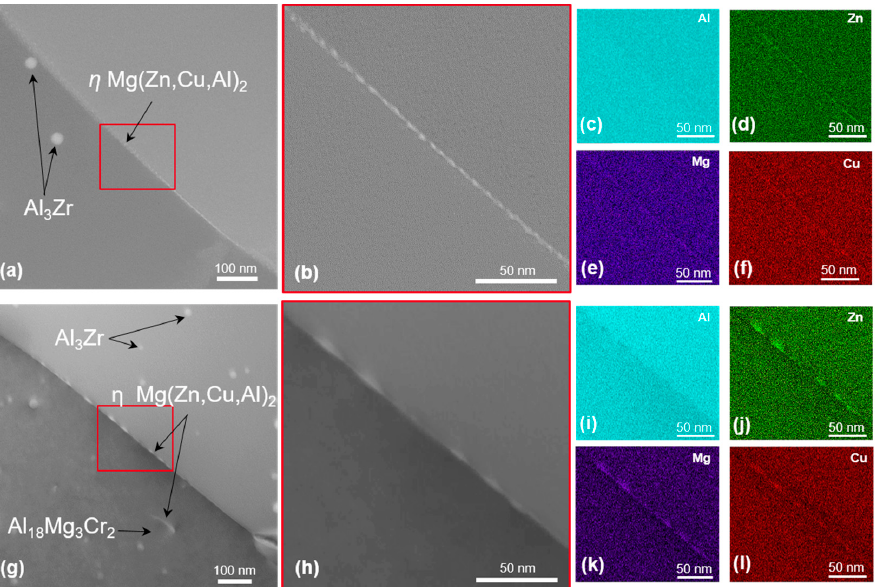
Figure 8. STEM dark-field images and EDX maps of alloys in T4 state: ( a – f ) 7449 and ( g – l ) 7449+Cr. The red boxes indicate the region of interest for EDX mapping.